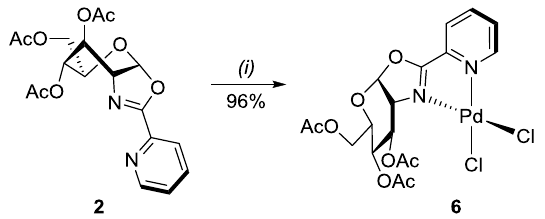
Scheme 3. Complexation of PYOX ligand 2 with Pd(II). Reagents and conditions: ( i ) PdCl 2 (cod), DCE,